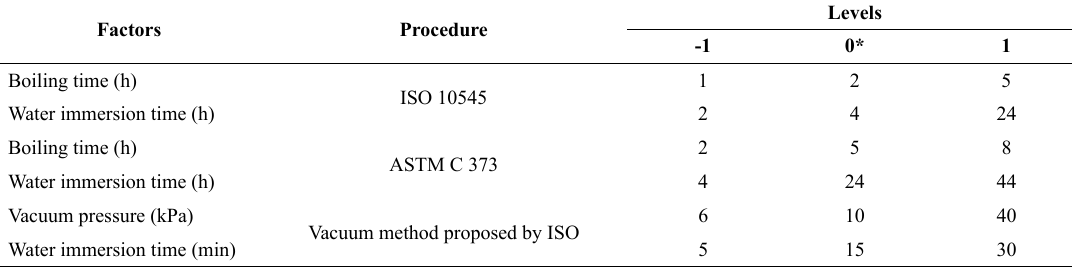
Table 1. Experimental design with the combinations among each factor.